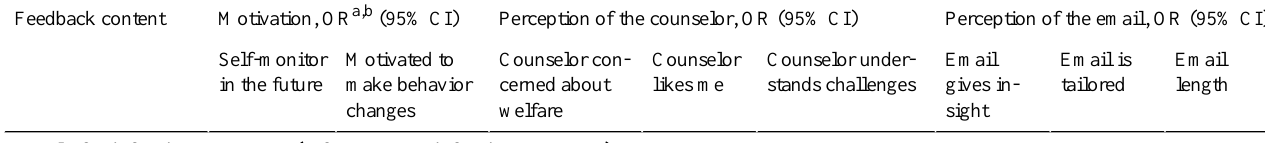
Table 2. Odds ratios (with 95% CI) of different combinations of reinforcing comments and areas for change on all outcome measures